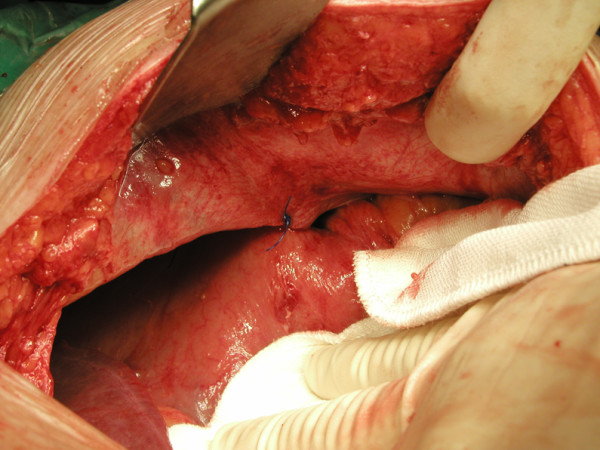
Anterior gastropexy.